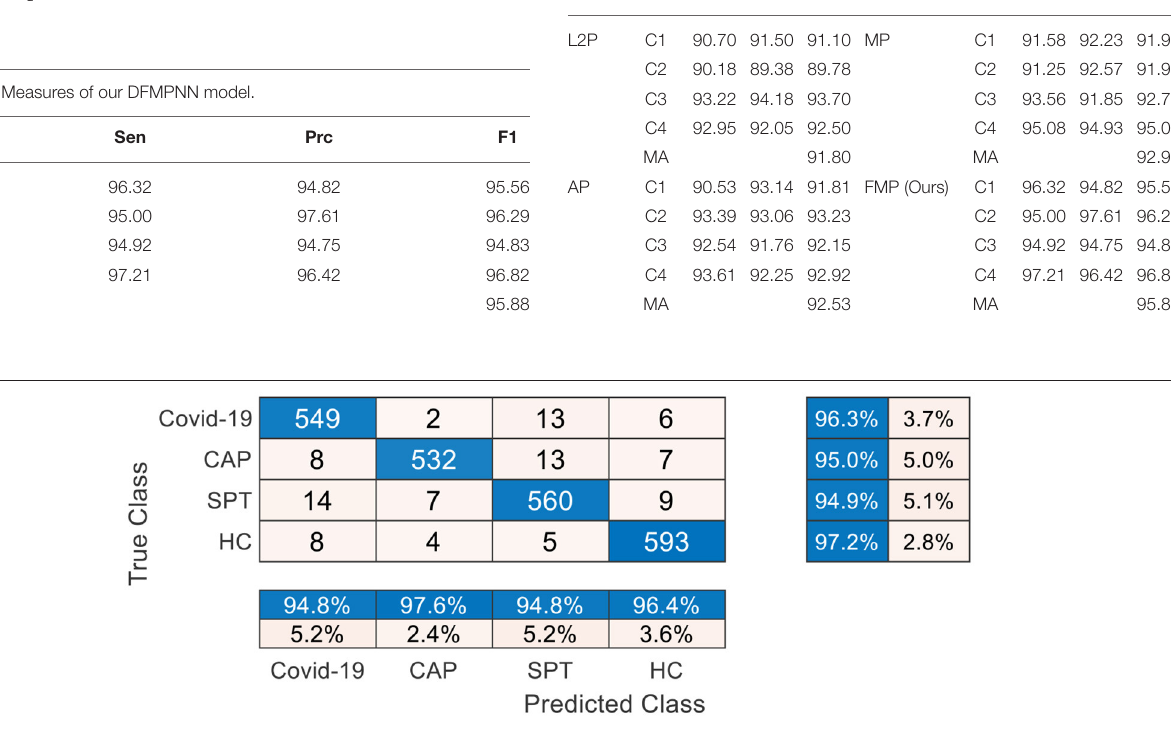
FIGURE 10 | Confusion matrix of our DFMPNN